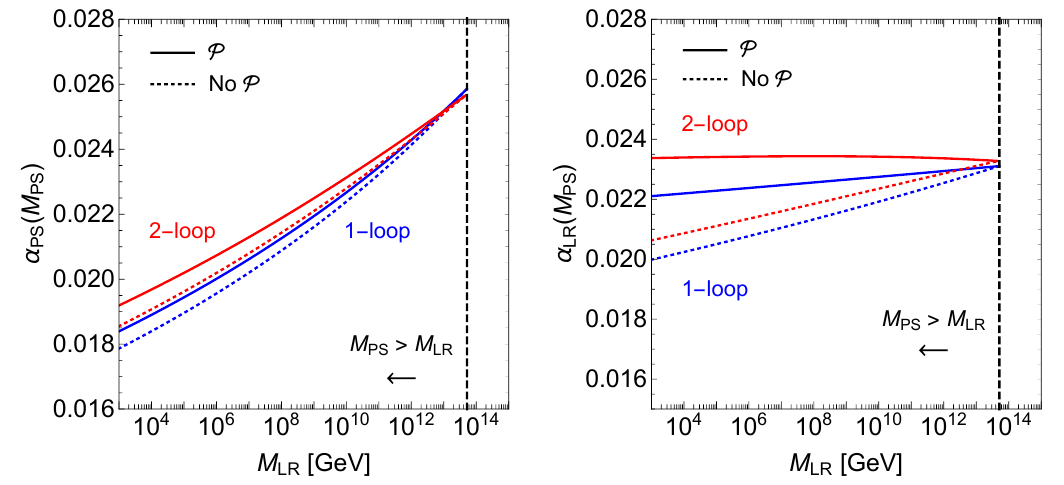
Figure 2 . Pati-Salam gauge coupling (left panel) and Left-Right gauge coupling (right panel) at the Pati-Salam uni(cid:12)cation scale, as a function of the Left-Right symmetry breaking scale.